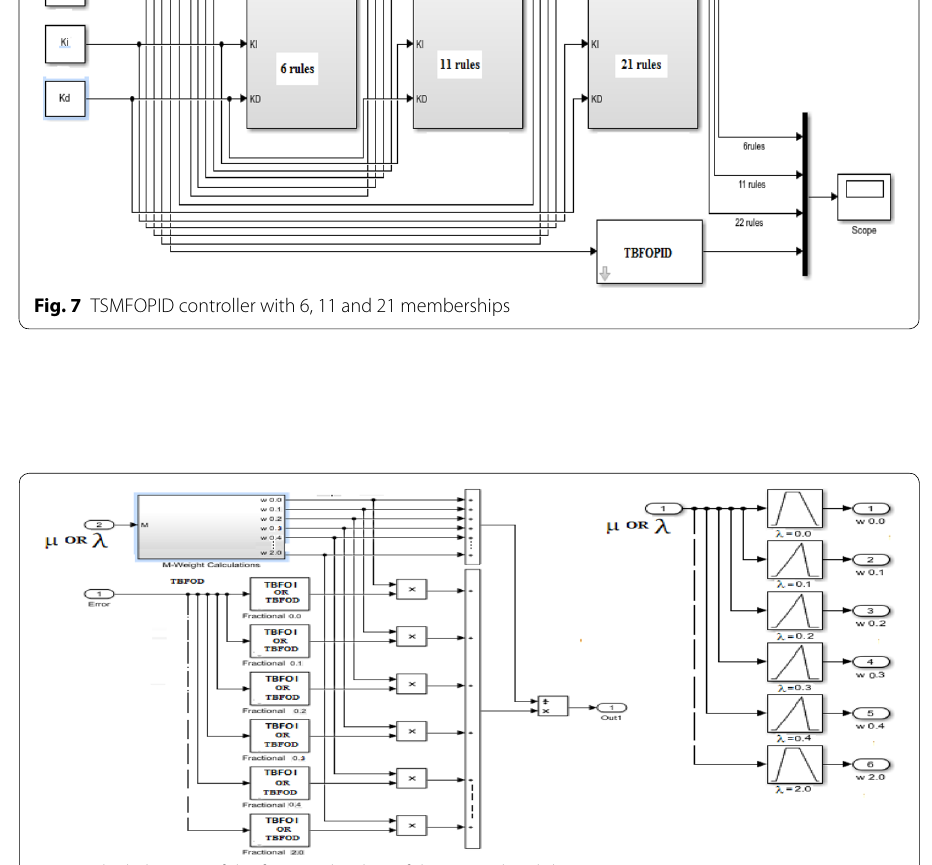
Case 1: Comparison between fractional integral I λ for TSMFOPID and TBFOPID controllers